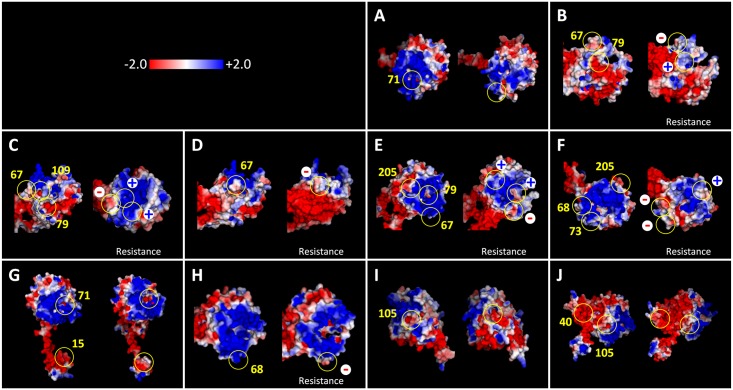
Poisson-Boltzmann electrostatic potential mapped onto the Van der Waals surfaces of pvr2/eIF4E1 protein.The electrostatic potential of the protein encoded by the reference allele pvr2+(left) is compared with that of alleles (right) pvr1+ (A), pvr21 (B) pvr22 (C), pvr24 (D), pvr27 (E), pvr29 (F), pvr217 (G), pvr223 (H), pvr224 (I) and pvr225 (J). Panels A, G, I and J compare the protein encoded by pvr2+ with those encoded by potyvirus susceptibility alleles, while panes B-F and H compare the protein encoded by pvr2+ with those encoded by potyvirus resistance alleles.